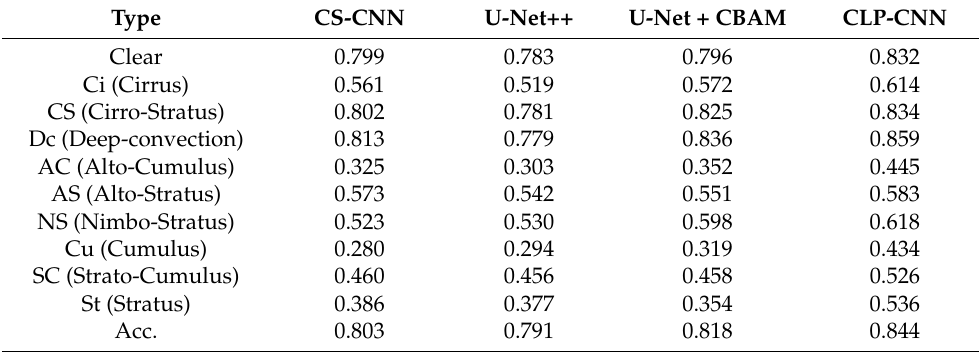
Table 4. The POD of the four models compared with the Himawari-8